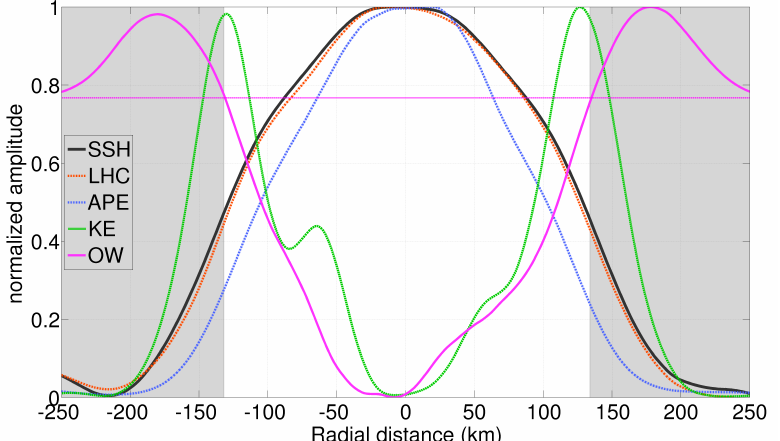
Figure 18. Normalized cross-eddy profiles of in situ steric height (SSH; gray line), local heat content (LHC; dashed red line), available potential energy (APE; dotted blue line), kinetic energy (KE; dashed green line), and Okubo–Weiss parameter (OW; pink continuous line). The horizontal pink line shows the zero OW